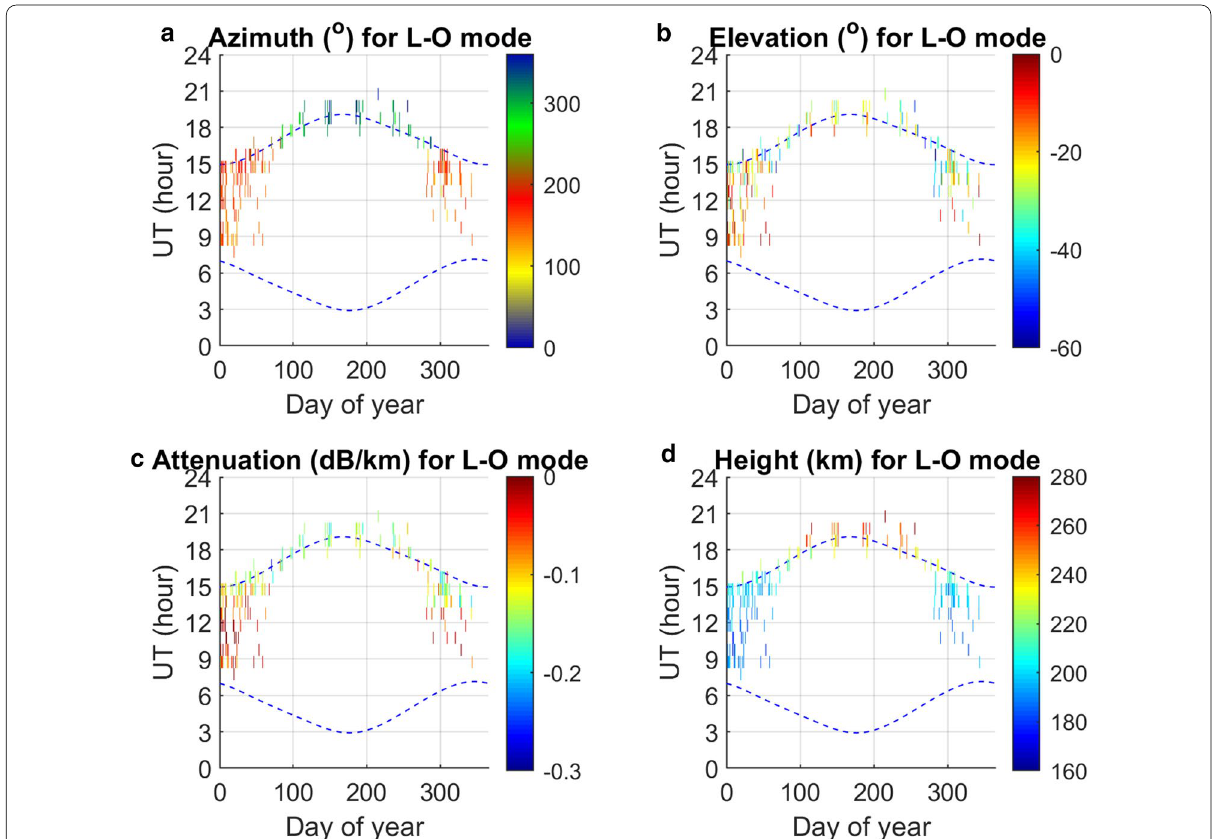
Fig. 4 Azimuth, elevation ǫ , attenuation A dBkm and height of observation for the period July 2014–June 2015 (solar maximum) and L-O mode. The values are color-coded. Dashed lines indicate times of sunrise and